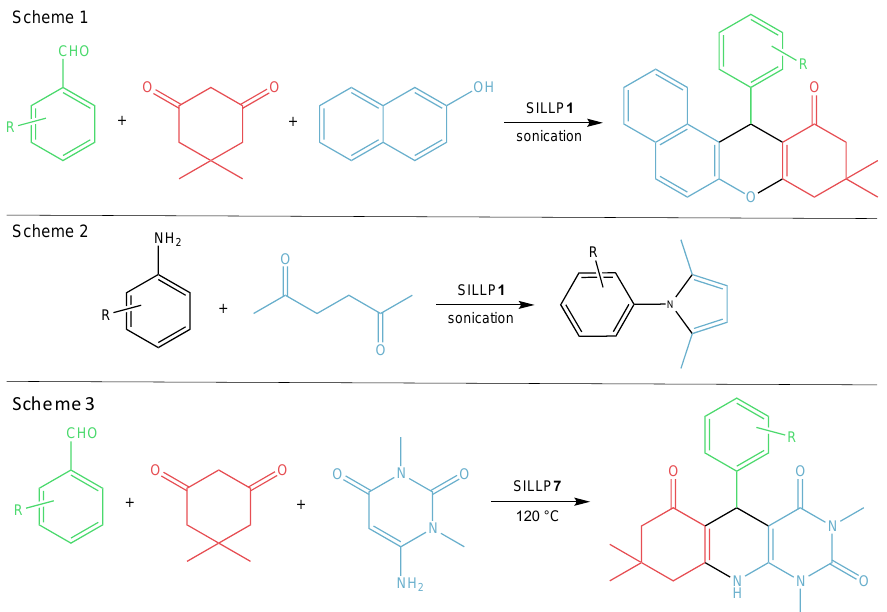
Figure 15. Silica-ferrite hybrid-based SILLP as the catalyst in synthesis of benzoxanthenes (Scheme 1), pyrroles (Scheme 2), pyrimido[4,5-b]quinolines (Scheme 3).